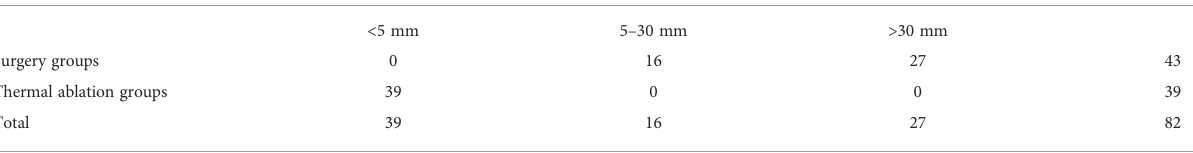
TABLE 8 Comparison of postoperative scar size between two